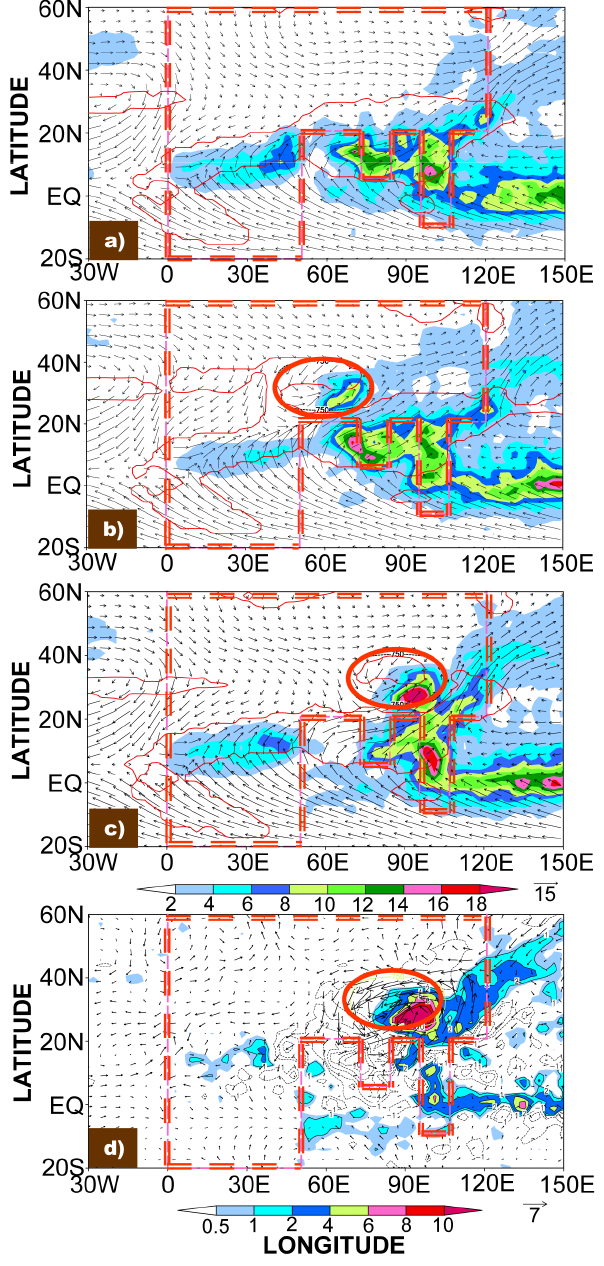
Fig. 10. Distributions of the 10-year July mean rainfall (color shad- ing, unit is mmd − 1 ) and wind at 925hPa (arrows, ms − 1 ) in the experiments NOMT (a) , MT60 (b) , and MT90 (c) . The differences between MT90 and NOMT are shown in (d) . The red lines in (a–c) mark the area where the change in wind direction between July and January exceeds 120 ◦ . The thick dashed line denotes the idealized coastline, and the thick ellipse in (b–d) indicates land above 750m.